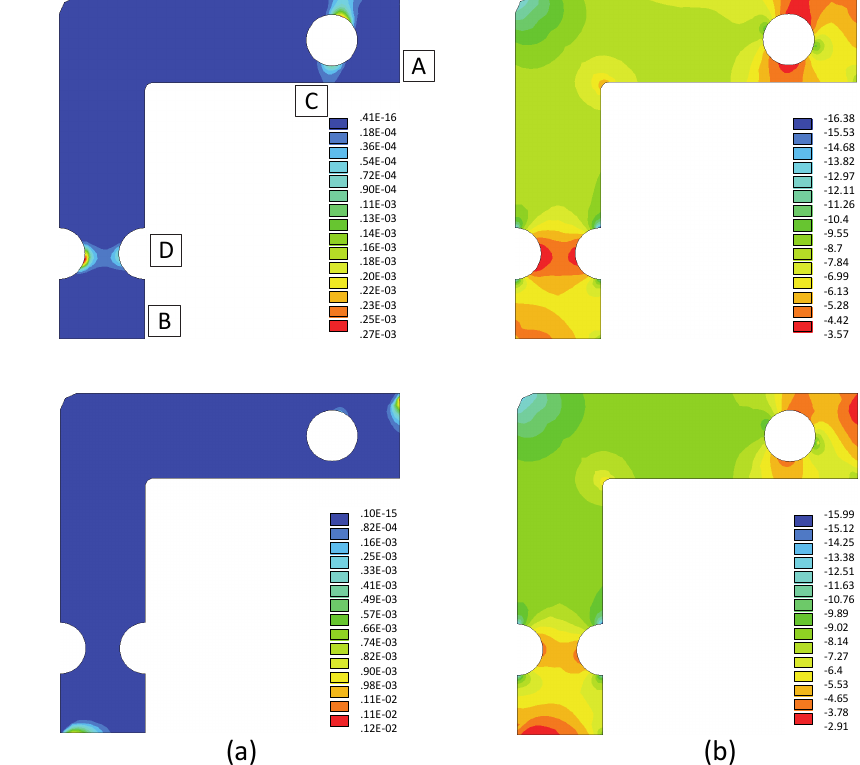
Figure 8: Comparison of damage maps for Material 1 vs. Material 2. Figs. (b) plots of log 10 (D) from Figs. (a). Indeed, in a FE model the stress ratio ρ ref may vary over a range of values, which depend on the variation of the local multiaxial state of stress among nodes. Fig. 9(a) illustrates the distribution of ρ ref values obtained in numerical simulations. This distribution holds for both materials, being ρ ref only a function of the local stress, not of material. The figure also marks the values at which the multiaxial stress is close to uniaxial tension or torsion, and the regions A, B, C, D identified in Fig. 8(a) (top). The values of ρ ref then measure if the stress in a point is more tension-like or